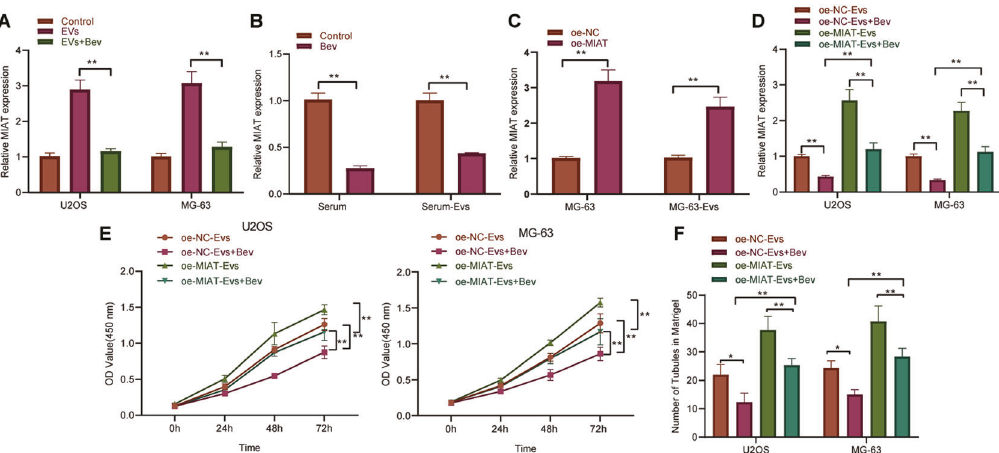
Fig. 3 Bev disrupts the delivery of EV-MIAT to osteosarcoma cells to suppress cell proliferation and angiogenesis. A MIAT expression was determined by RT-qPCR in U2OS and MG63 cells treated with Bev. B MIAT expression determined by RT-qPCR in the serum of mice and serum- EVs following Bev treatment. C MIAT overexpression ef fi ciency was determined by RT-qPCR in MG63 cells and MG63 cell-derived EVs. D MIAT expression determined by RT-qPCR in U2OS and MG63 cells treated with oe-NC-EVs + Bev, oe-MIAT-EVs, or oe-MIAT-EVs + Bev. E Proliferation of U2OS and MG63 cells treated with oe-NC-EVs + Bev, oe-MIAT-EVs, or oe-MIAT-EVs + Bev measured by CCK-8 assay. F Angiogenesis of U2OS and MG63 cells treated with oe-NC-EVs + Bev, oe-MIAT-EVs, or oe-MIAT-EVs + Bev measured by microtubule formation in vitro. ** p < 0.01. n = 6 for mice upon each treatment. All experiments were conducted three times independently.